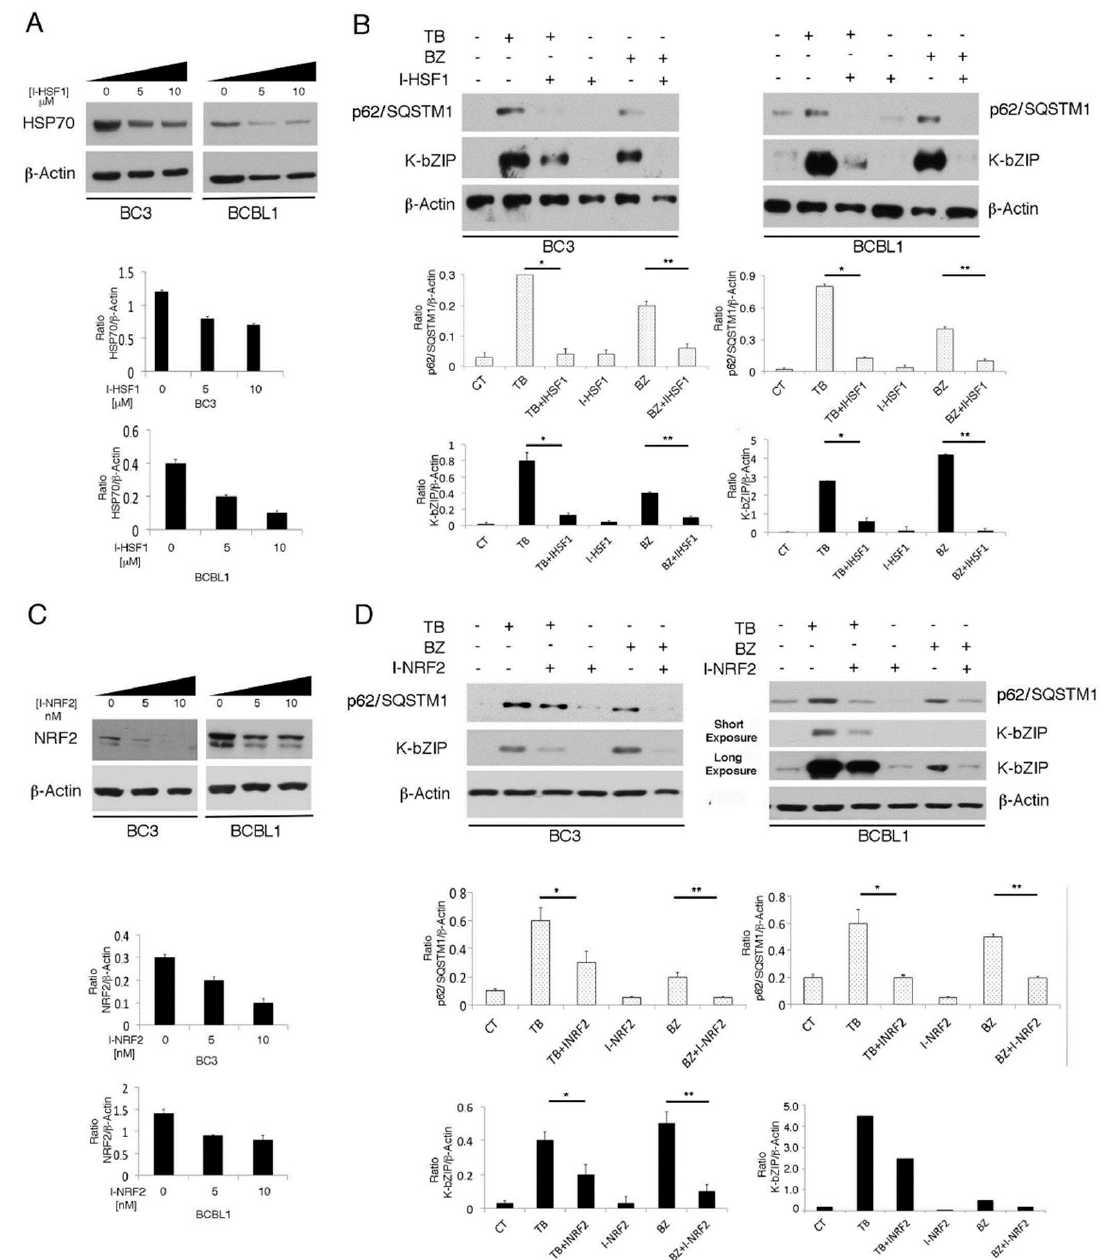
Figure 6. HSF1 and NRF2 inhibition counteracts the KSHV lytic cycle induced by TB and BZ in PEL cells. ( A ) and ( C ): HSF1 and NRF2 activity was inhibited in a time-course assay by I-HSF1 (KRIBB11) or I-NRF2 (brusatol), as revealed by HSP70 or NRF2 expression evaluated by western blotting